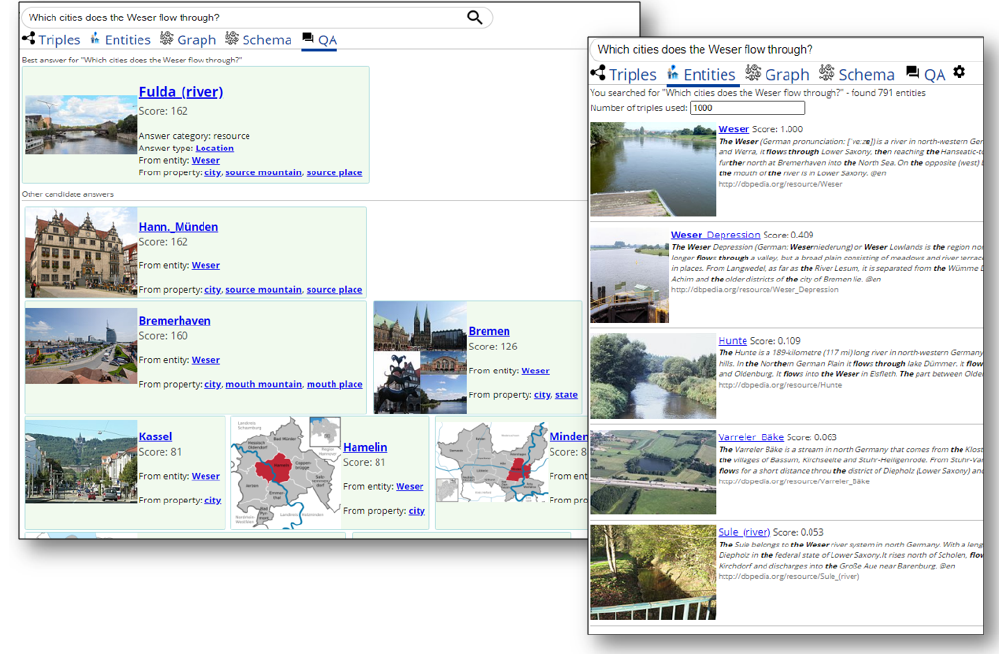
Figure 7. Search results for the query “ Which cities does the Weser flow through?